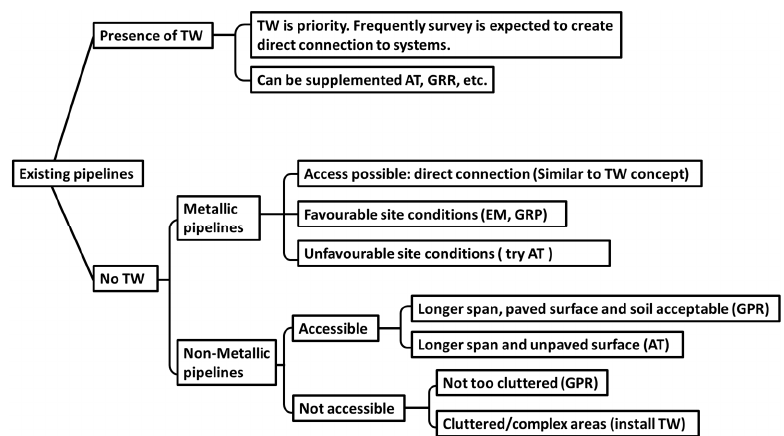
Figure 21. Selection of pipe localization methods considering di ff erent conditions, modified from